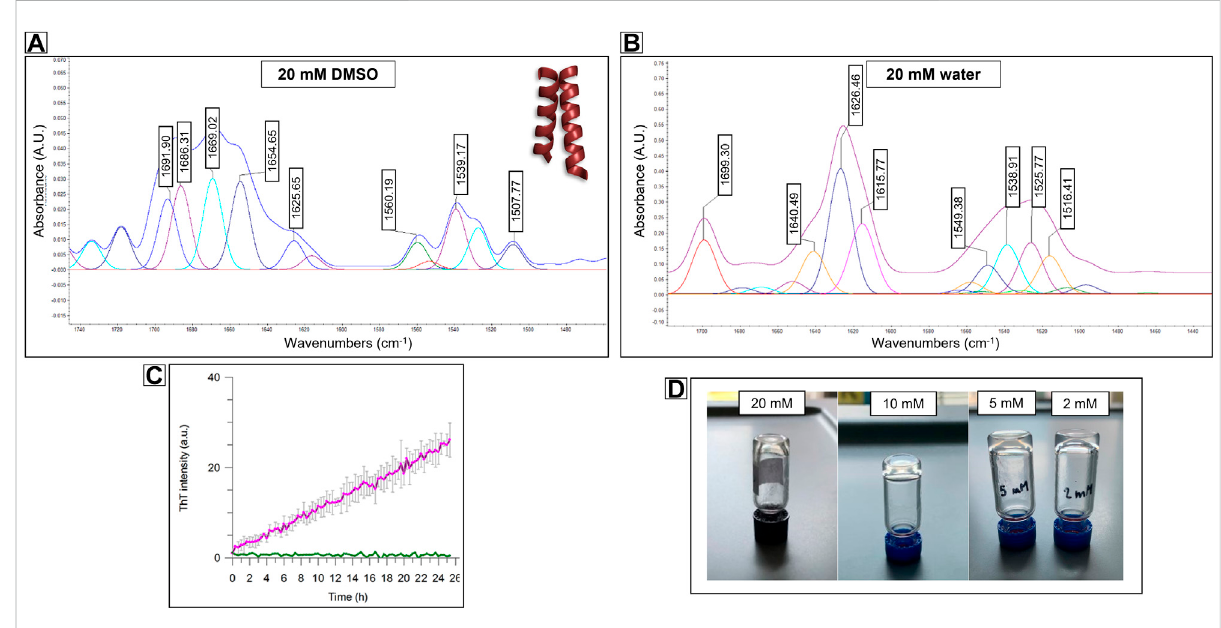
FIGURE 5 FT-ATRspectraofCompoundPMP-2at20 mMconcentrationin (A) DMSOand (B) inwater.InDMSOthepentamericsignalofacoiled-coillike structure can be recognize, while in water the β -sheet conformation is predominant. (C) Stable-to-inversion gel test on PMP-2 in Milli-Q water at 20 mM, 10 mM and 5 mM and 2 mM, respectively. (D) ThT fl uorescence assays showing 2 mM PMP-2 (purple trace) aggregation over 24 h. The concentration of the control PMP-2 is 0.1 mM (green